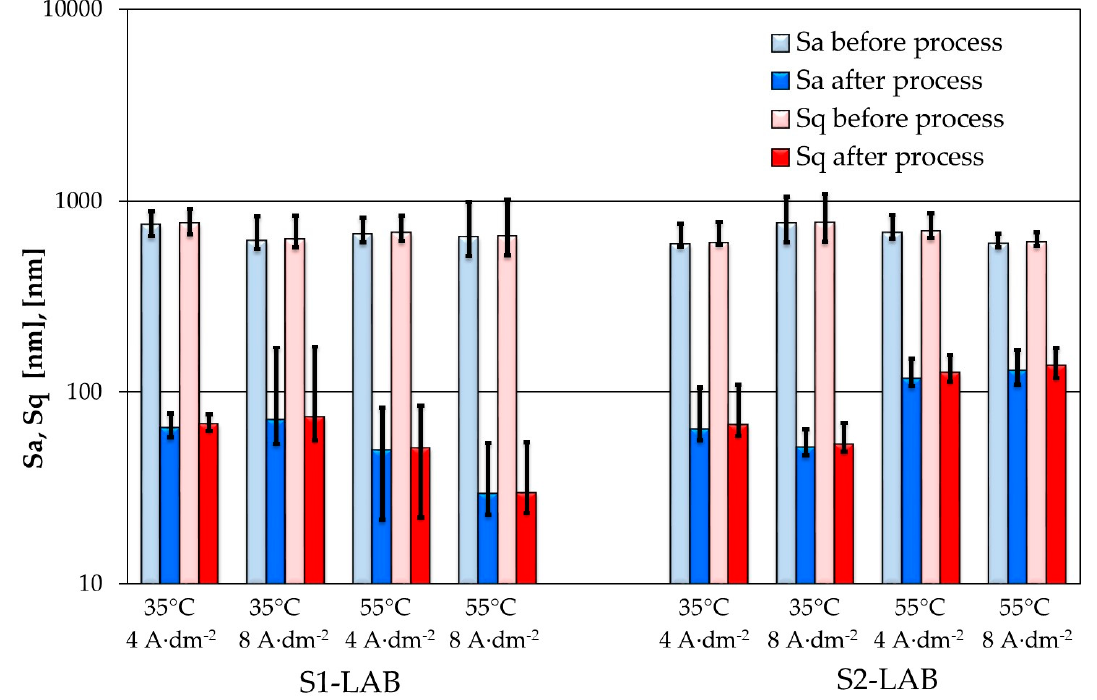
Figure 5. S a and S q parameters of samples surfaces before and after electropolishing in various parameters of temperature and current density.